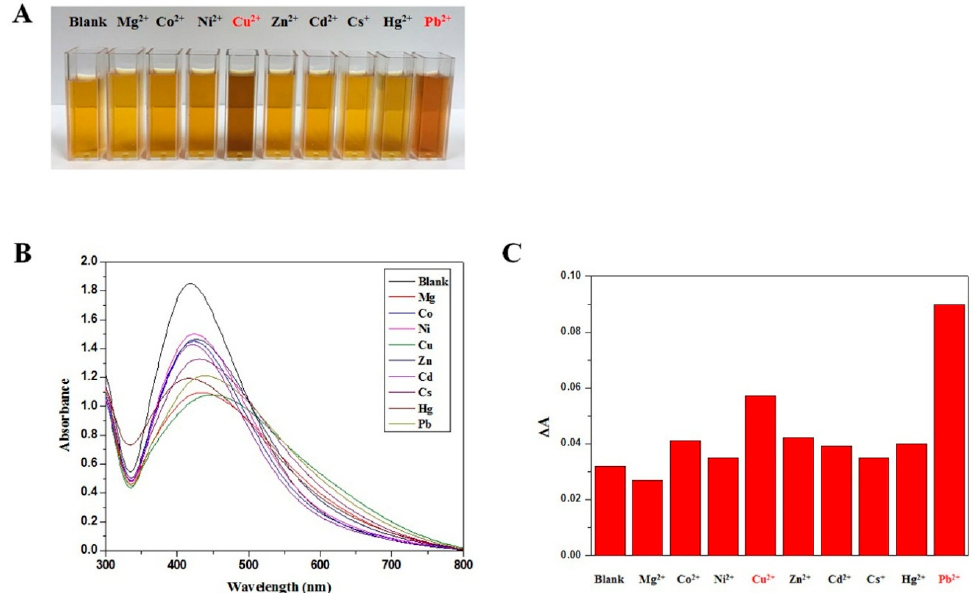
Figure 3. ( A ) Photographic images of polyDOPA-AgNPs in the presence of various metal ions; ( B ) UV–Vis absorption spectra of polyDOPA-AgNPs solution after mixing with 0.1 μ M metal ions;